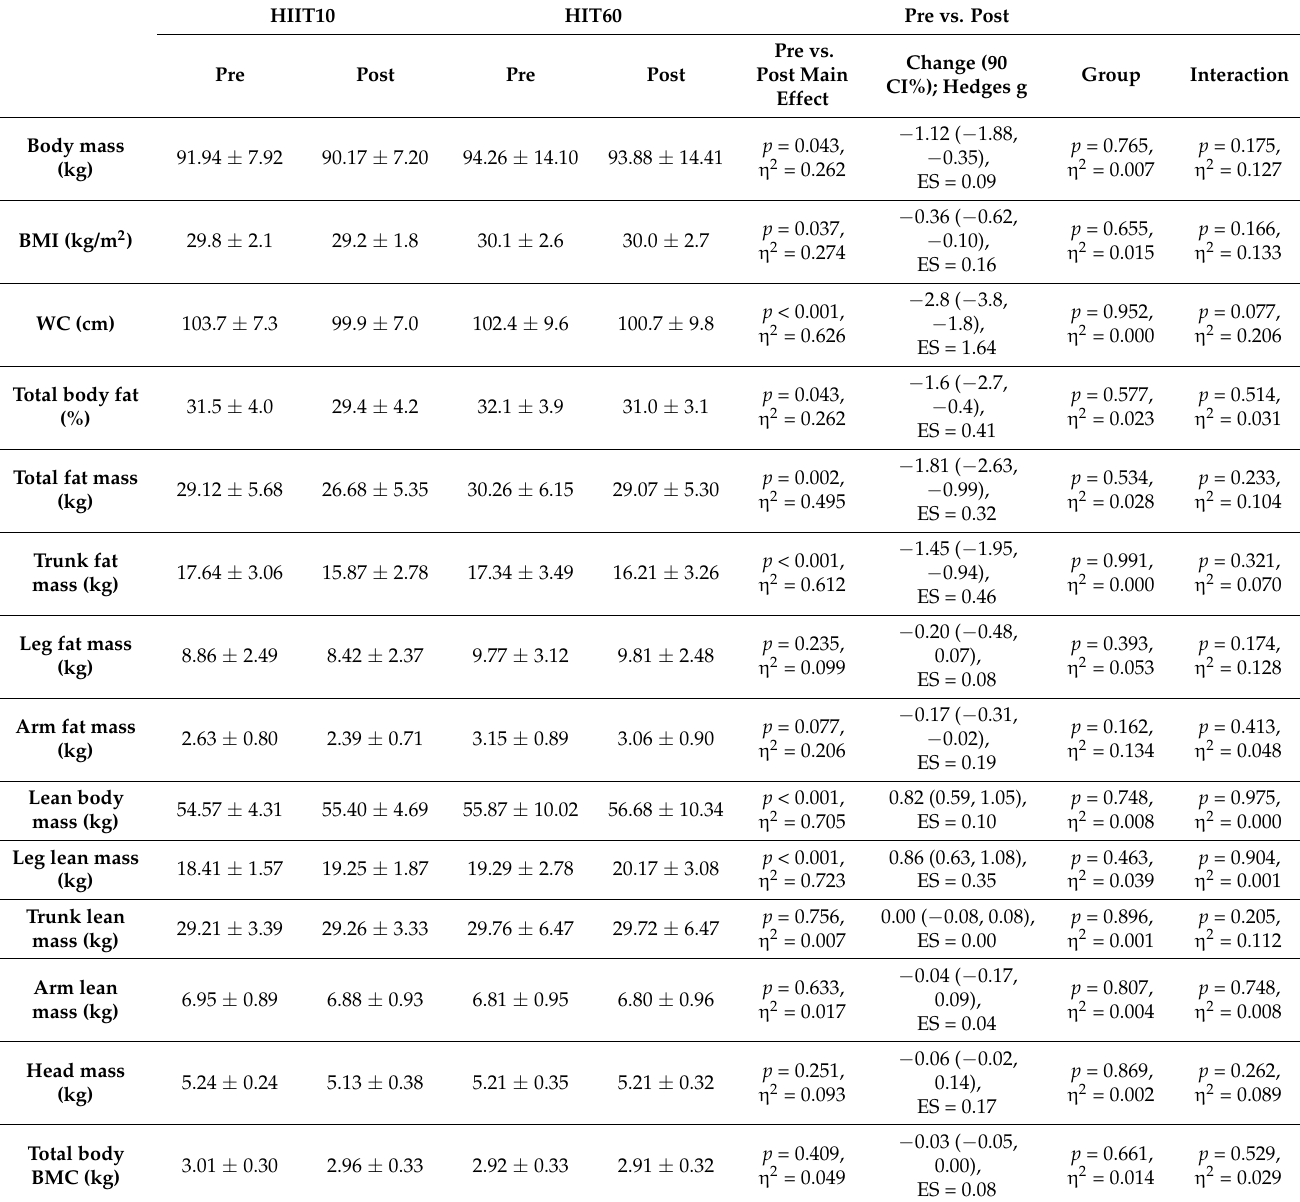
Values are means ± standard deviation. Bold font highlights statistically significant differences. 90% CI, 90% confidence interval; η 2 , partial eta squared; ES, effect size; BMC, bone mineral content; BMI, body mass index; WC, waist